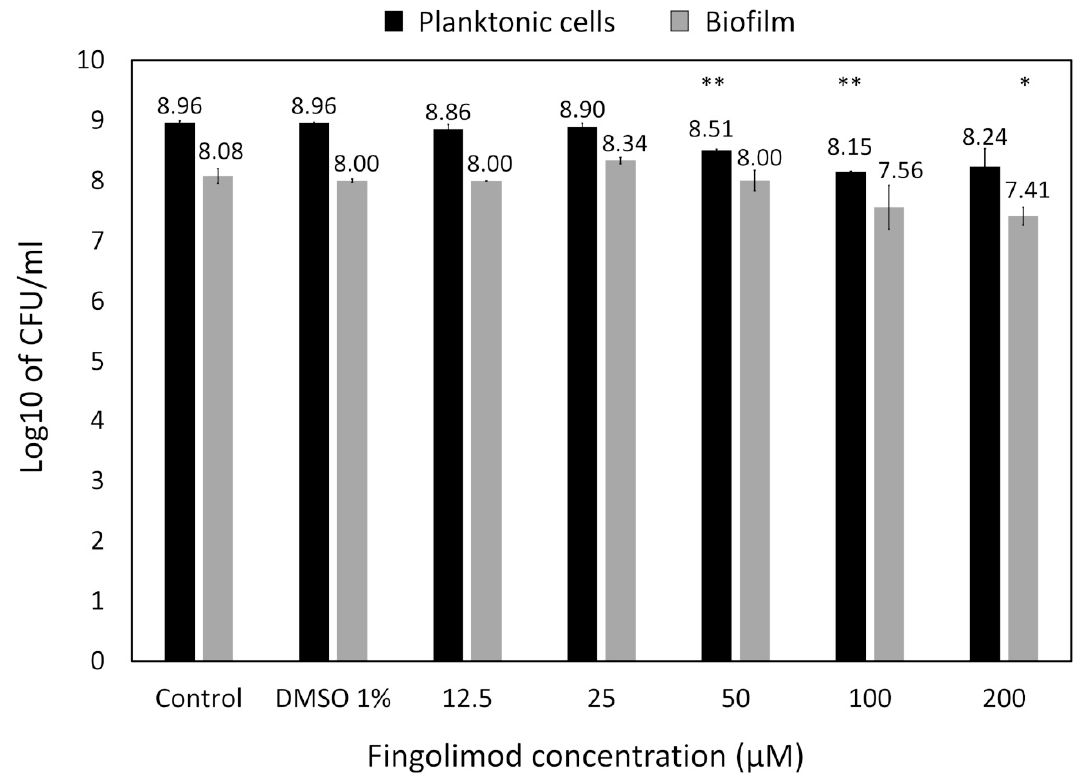
Figure A1. CFU count of E. coli planktonic solution and biofilm after an 18 h treatment with fingolimod in the pre-exposure mode. Results are from two distinct experiments with each three biofilm replicates for all concentrations ± SD.